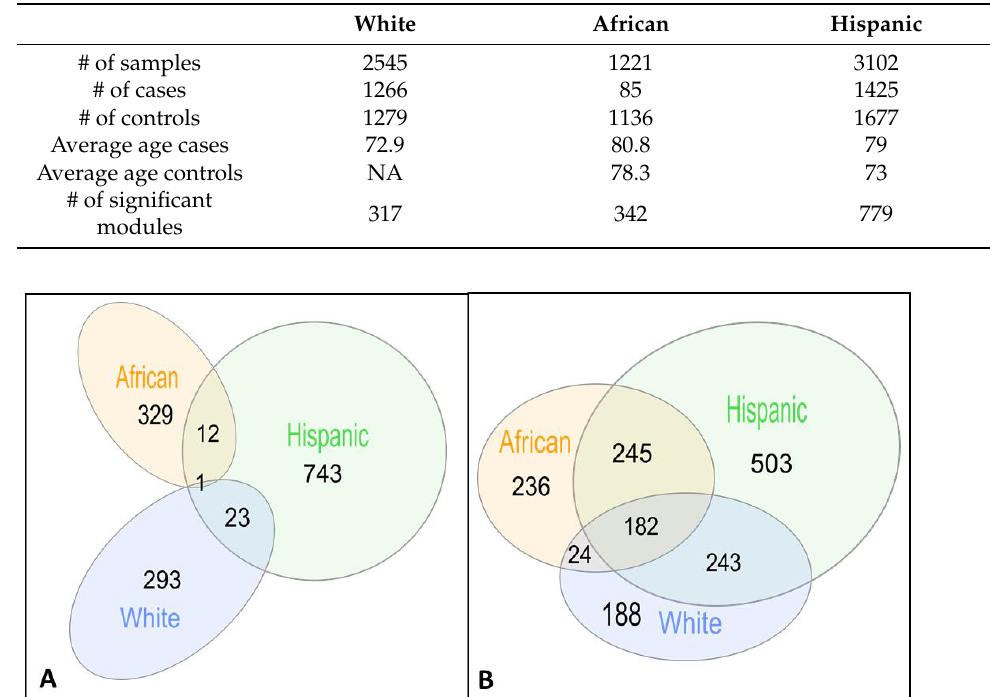
Table 1. Summary statistics for the studies used in our analysis.